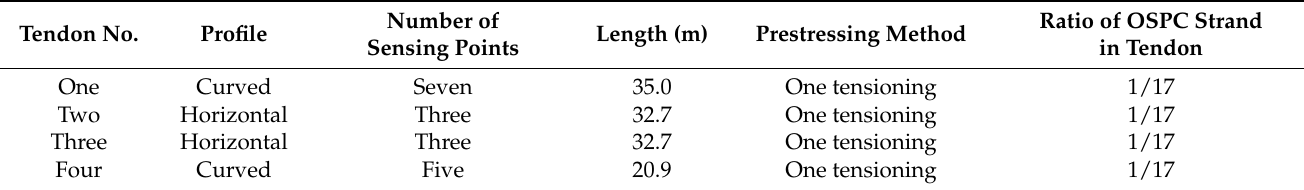
Figure 5. Layout of OSPC strands: ( a ) At support A; ( b ) At Support B; ( c ) At central section C; ( d ) Overall layout and sensing points. Table 1. Characteristics of tendons with OSPC strand.